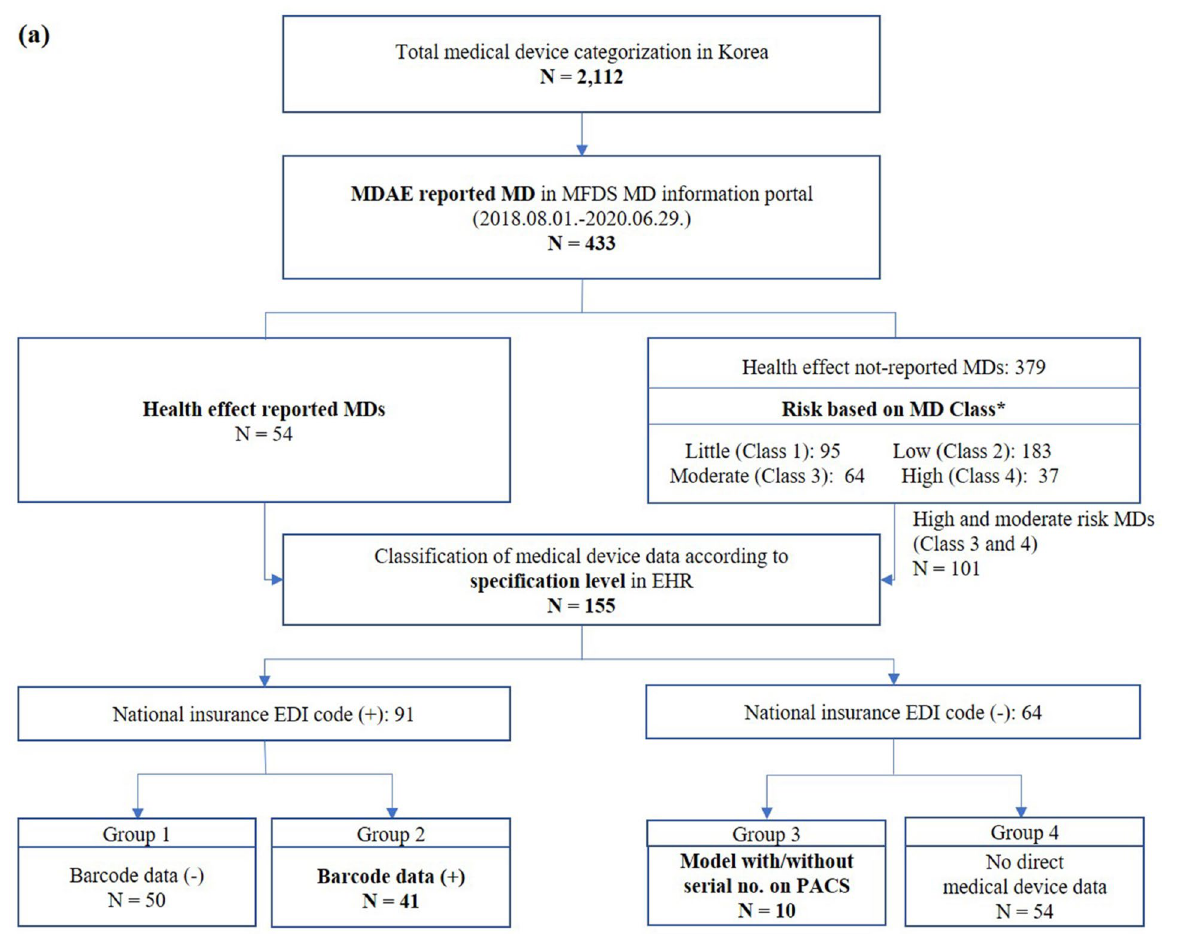
Figure 2. A total of 155 medical devices were finally enrolled for the investigation of medical device data on EHR ( a ). Medical device information EHR was classified into four groups ( b ). MDAE medical device